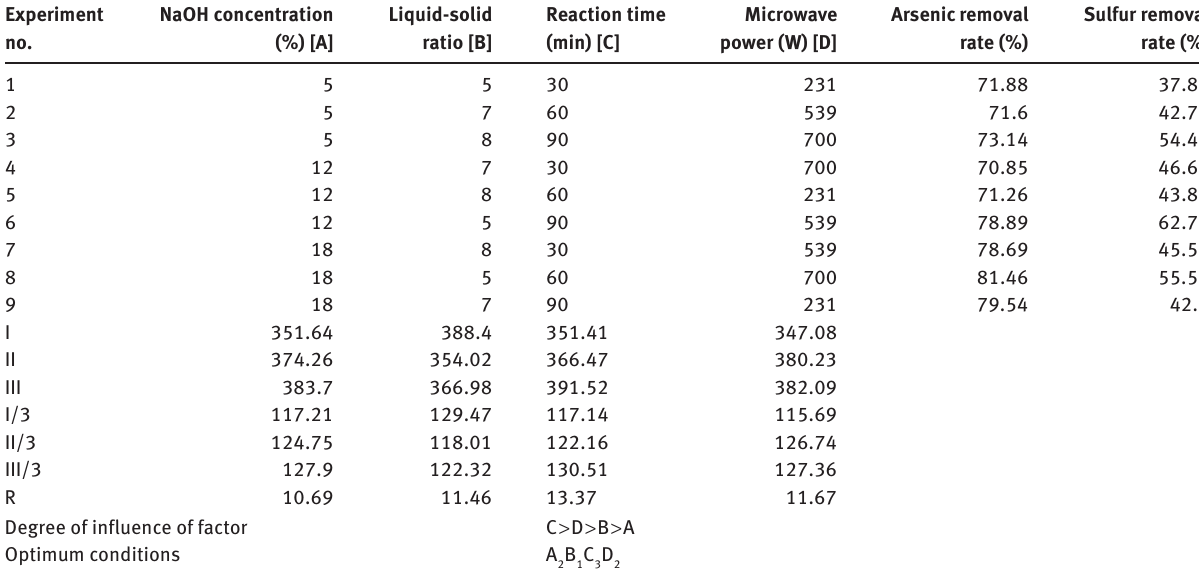
Table 2: Orthogonal test conditions and results of alkaline leaching of arsenic.